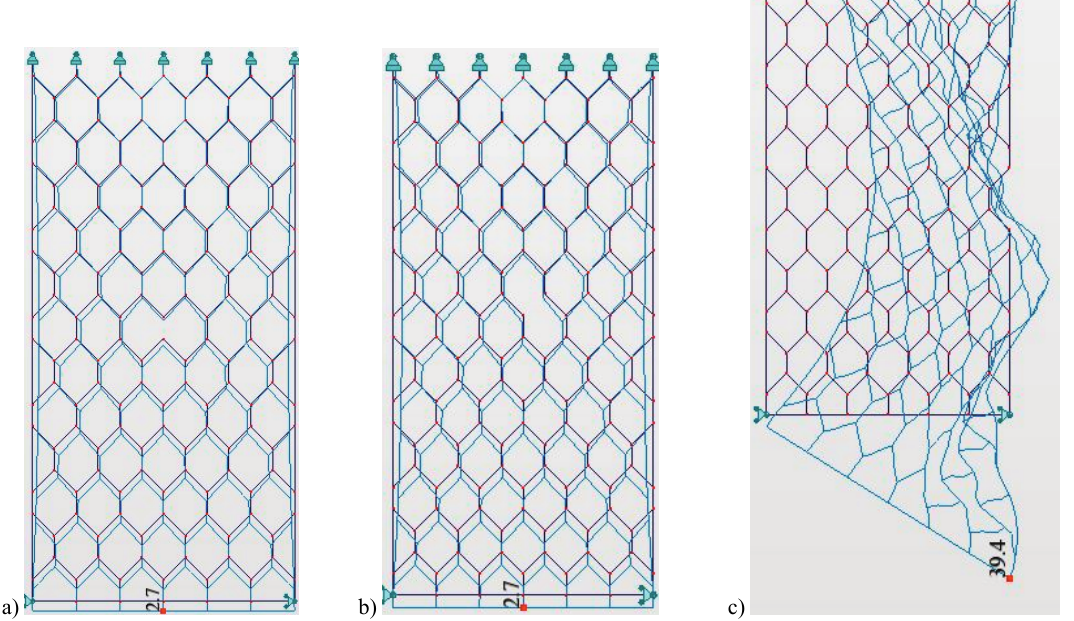
Fig. 7. Displacement of woven mesh nodes with damaged: